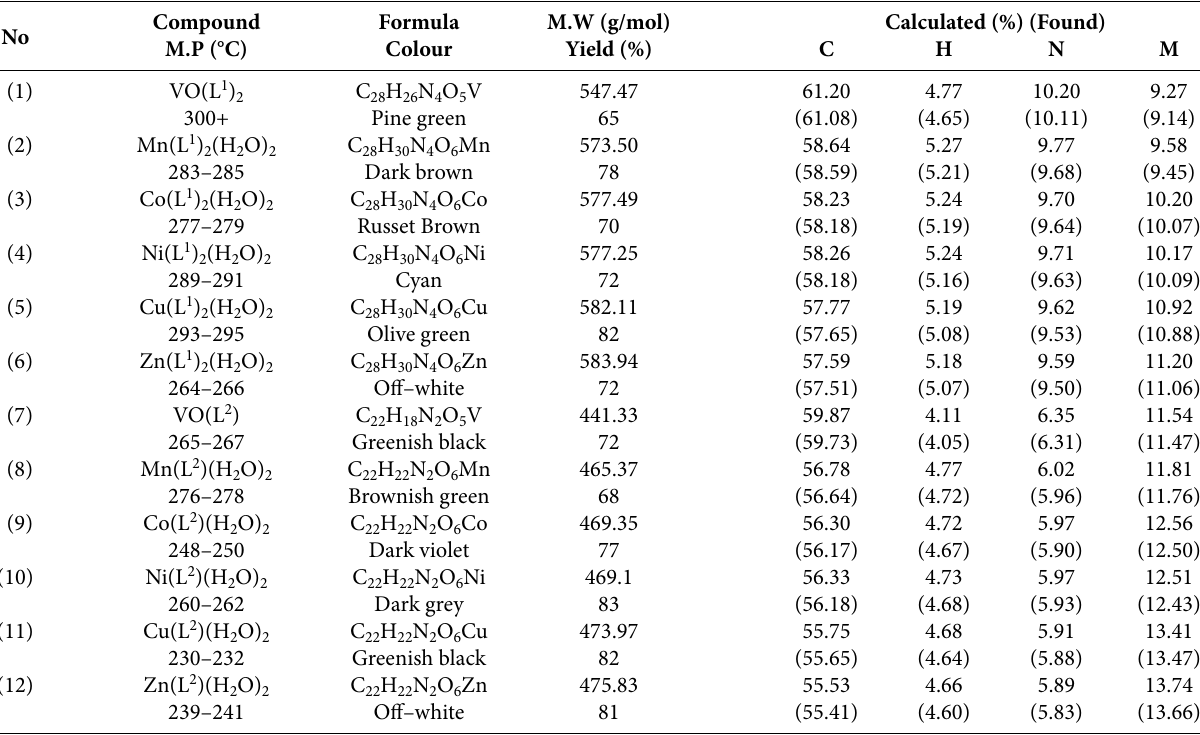
Table 1. Physical, analytical and elemental details of metal complexes (1) –